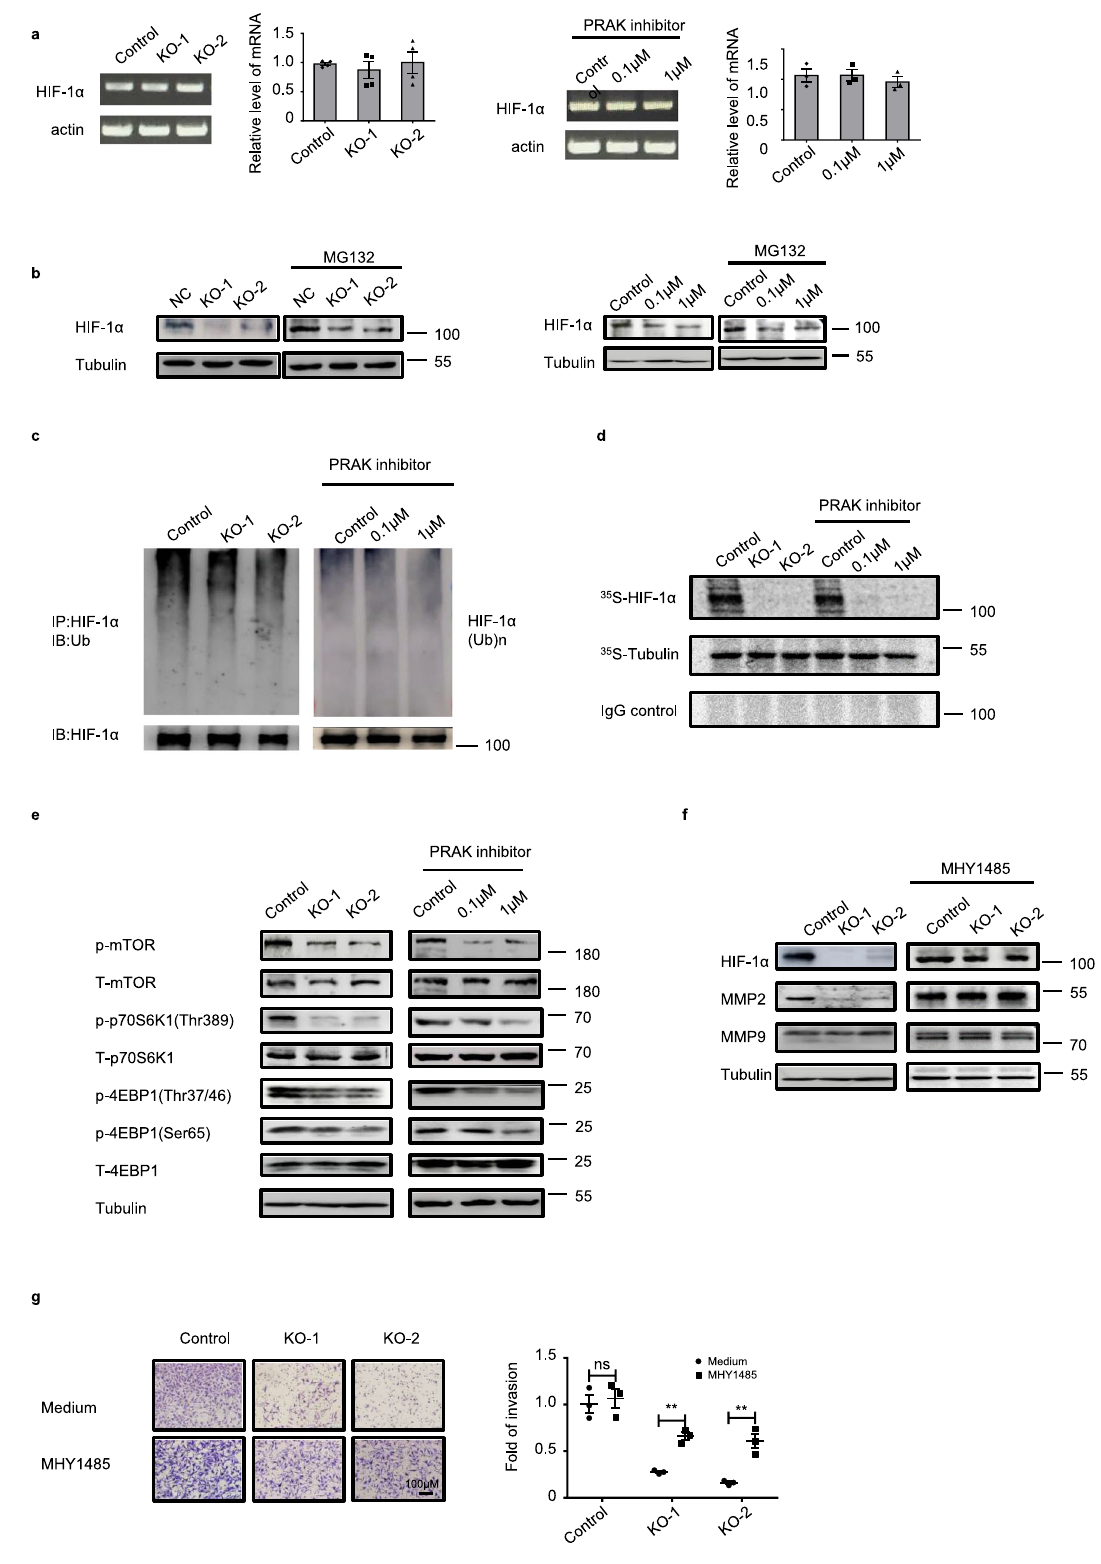
In summary, both genetic and pharmacological evidence points to a potent pro-metastatic activity of PRAK, which is partly mediated by enhanced HIF-1 α translation. Targeting PRAK holds promise in the intervention of tumor